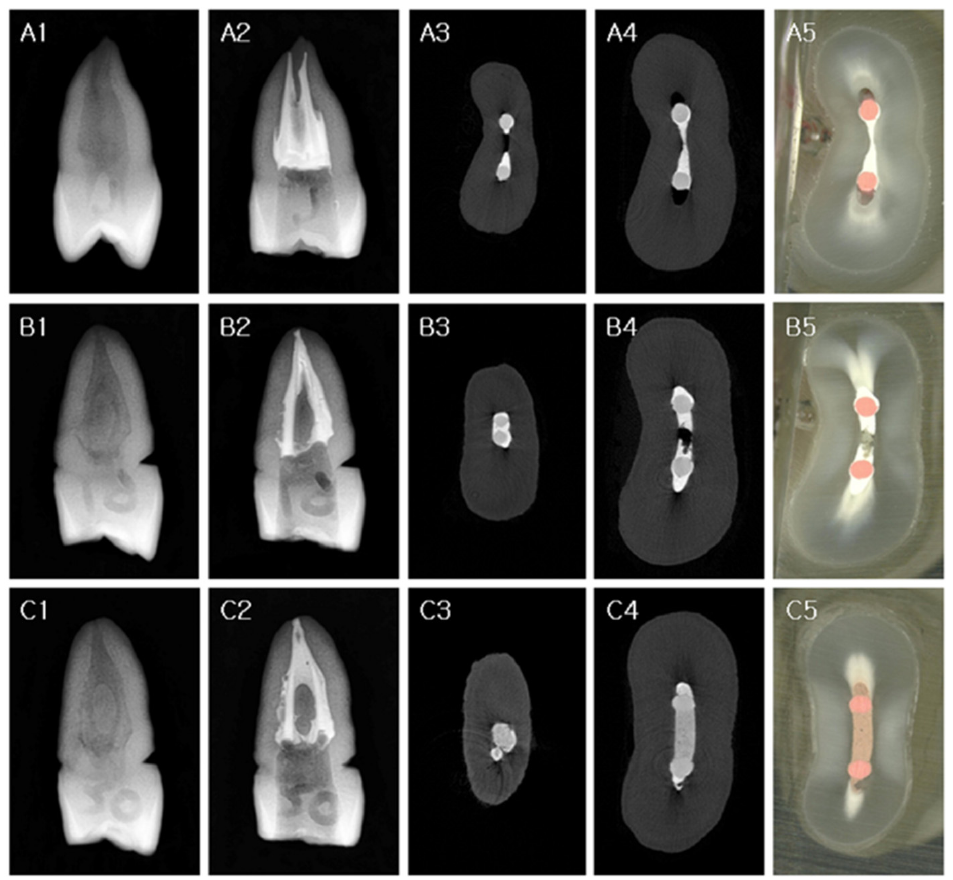
Figure 2. Representative images of each group from standard radiographs, micro-CT scans, and light microscopes. ( A1 – A5 ) SE group, ( B1 – B5 ) VE group, ( C1 – C5 ) VG group.